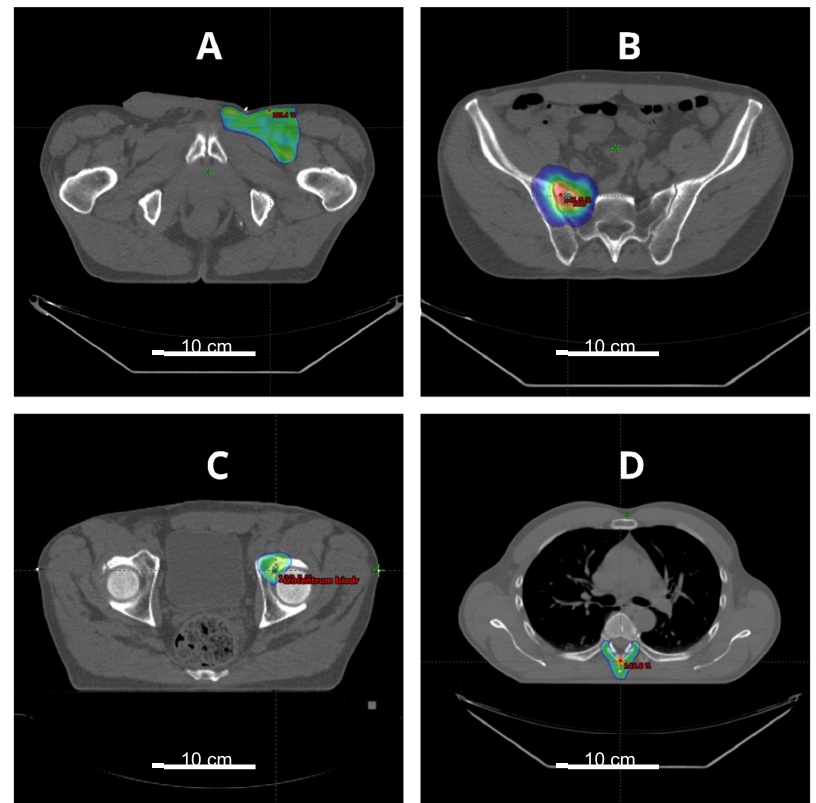
Figure 4. Radiotherapy plans in a patient with epithelioid sarcoma. ( A ) Adjuvant radiotherapy after resection of the primary tumor; ( B – D ) Stereotactic body radiotherapy for oligometastases in the same